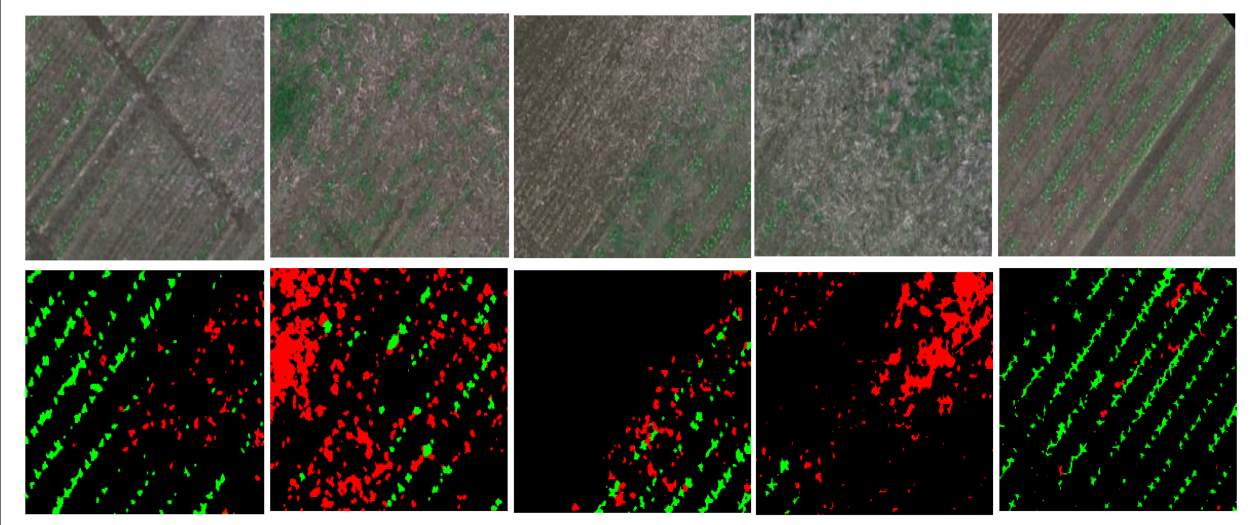
FIGURE 4 | Image samples with ground truth mask from WeedMap. Green denotes the crop, Red denotes the weed, and Black denotes the background